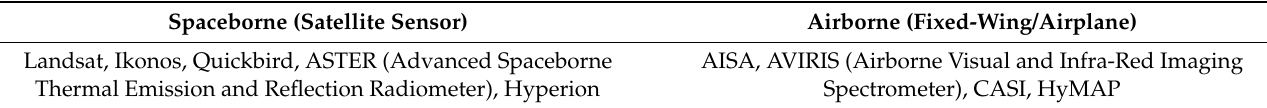
Table 2. Type of platform for hyperspectral image acquisition